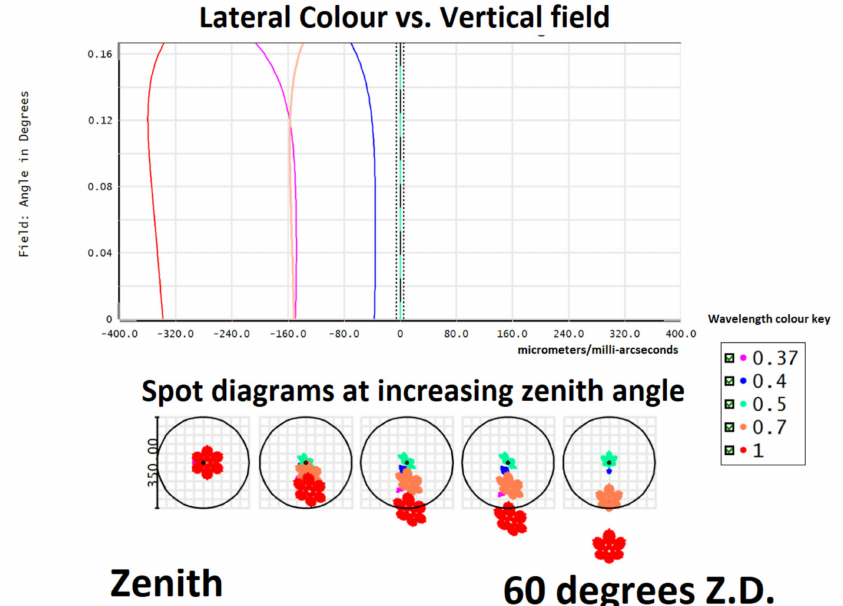
Figure 6. ( Top ) Lateral colour vs. field plot for the R-ADC type GMT C-ADC baseline design for maximum (60 degree) zenith distance. ( Bottom ) Spot diagrams, showing the growth of the secondary spectrum residual with increasing zenith distance ranging from zero to 60 degrees. Spots are shown in 0.35 arcsecond circles. Wavelength values are in microns in this and all subsequent